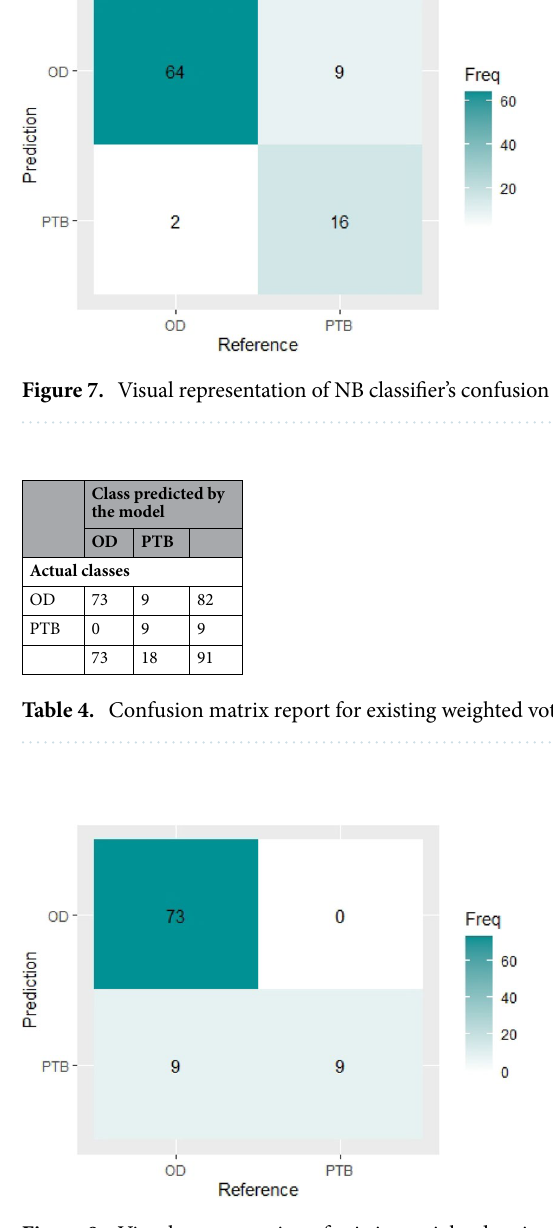
Figure 8. Visual representation of existing weighted voting ensemble method confusion